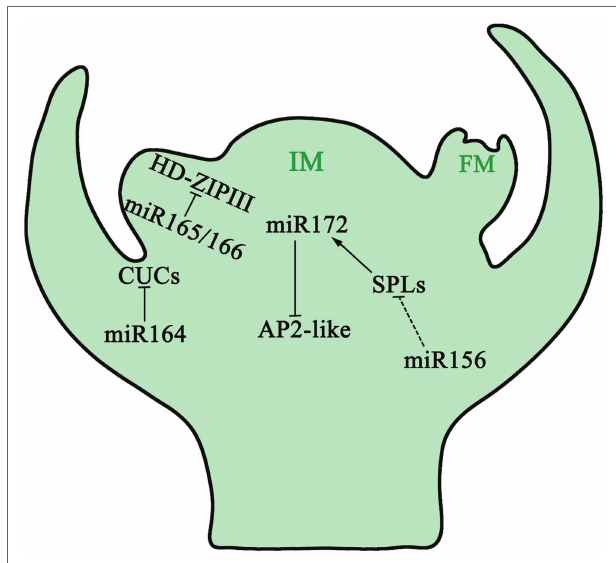
FIGURE 4 | The function of miRNAs in inflorescence meristem. As plants change growing phases from juveniles to adults, downregulation of miR156 dampens the inhibition of SPL expression, which in turn promotes miR172 transcription. miR172 triggers the development of inflorescence meristem by reducing the mRNA level of AP2-like genes. Spatiotemporal functions of miR165/166 and their targets HD-ZIP III genes, together with miR164, restrict the functions of CUCs in specific regions of the boundary to maintain the inflorescence meristem. miR156 decreases during IM development, whereas miR172 increases. IM: Inflorescence Meristem; FM: Floral